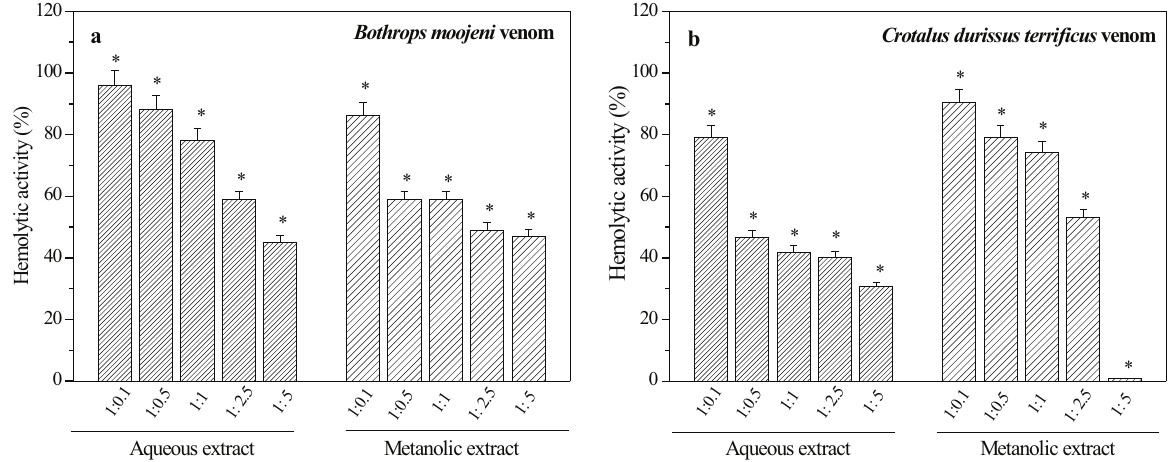
Figure 4 - Hemolytic activity (%) induced by the venoms of snakes from the species: Bothrops moojeni ( a ) and Crotalus durissus terrificus ( b ) previously incubated with aqueous and methanolic extracts of jabuticaba skin. Controles (+) containing only venom (30 µg) was considered as having 100% of activity. The results correspond to the average of triplicates of the data obtained for each proportion (venom: extract, w:w) and the standard deviations. *the averages differ statistically from the respective positive control by the Dunnett test